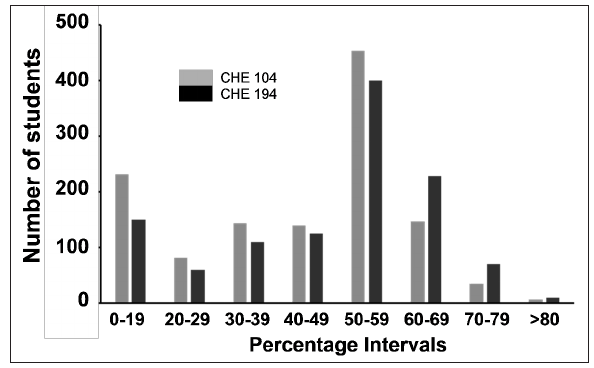
Performance of Extended BSc students in the first-year